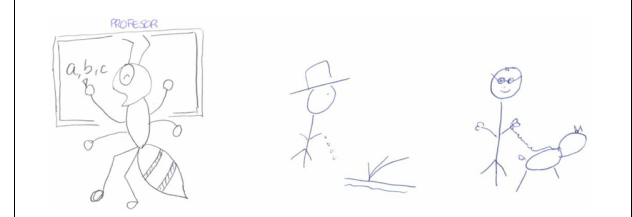
FIGURE 6 | E11’s drawings for the metaphor of the teacher as an ant explaining on the board (pre-test) and as a sower of seeds and a guide dog (post-test).